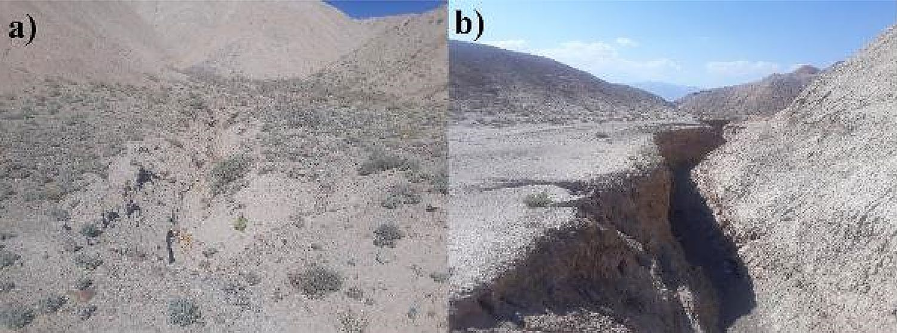
Figure 9. Representative field photographs of the mapped gullies in the study area. ( a ) Lat: 4072920.7; Long 869988.1 ( b ) Lat: 4045271.7; Long